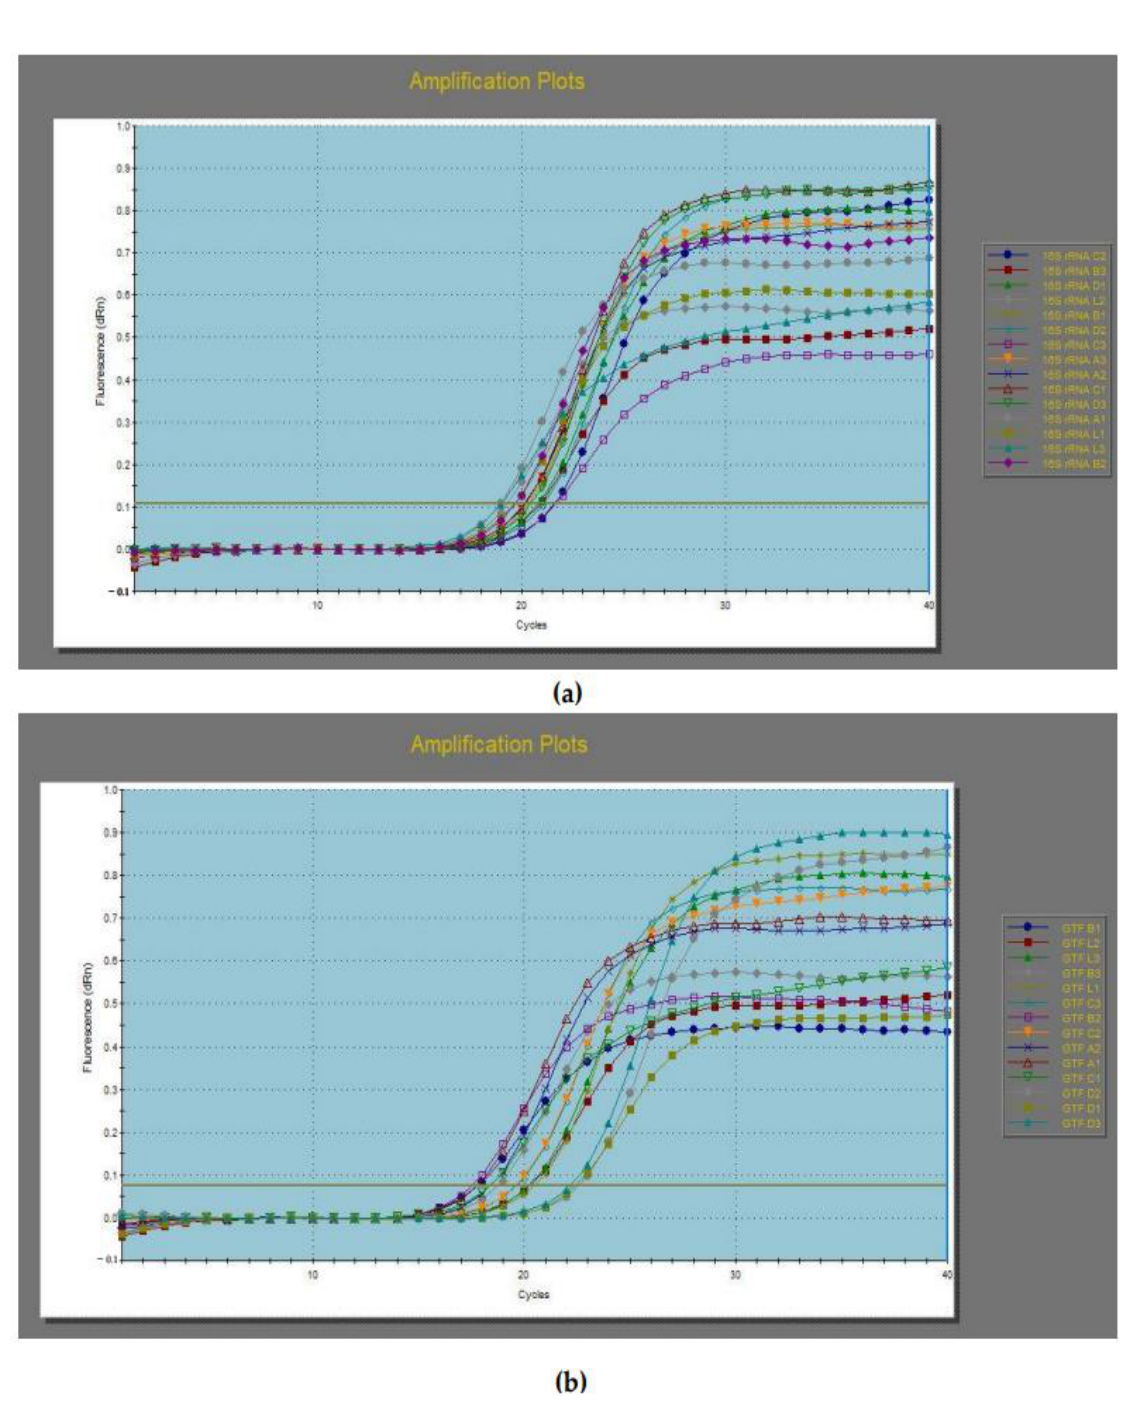
Figure 5. The gene expression on the RNA of the different treatments LGG (control), A3, B6, C9, D6 which were expressed as dissociation curves and calculation data for ( ∆ Ct, and ∆∆ Ct) using target genes involving ( a ) LAB 16S rRNA (control), and ( b ) glucan synthase gtf gene . Also, Table 2 and Figure 5 show the ∆∆ Ct technique used to compute the mean levels of gene expression across replicates, which were expressed as the fold change in